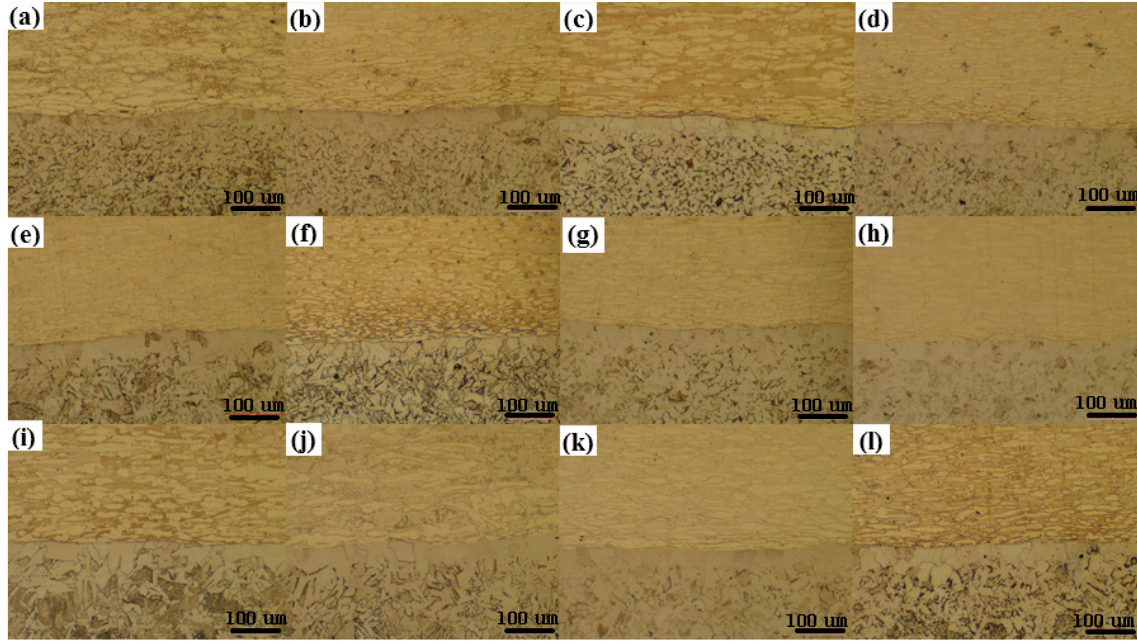
Figure 5. Microstructure of composite interface in large deformation area by optical microscope. ( a )